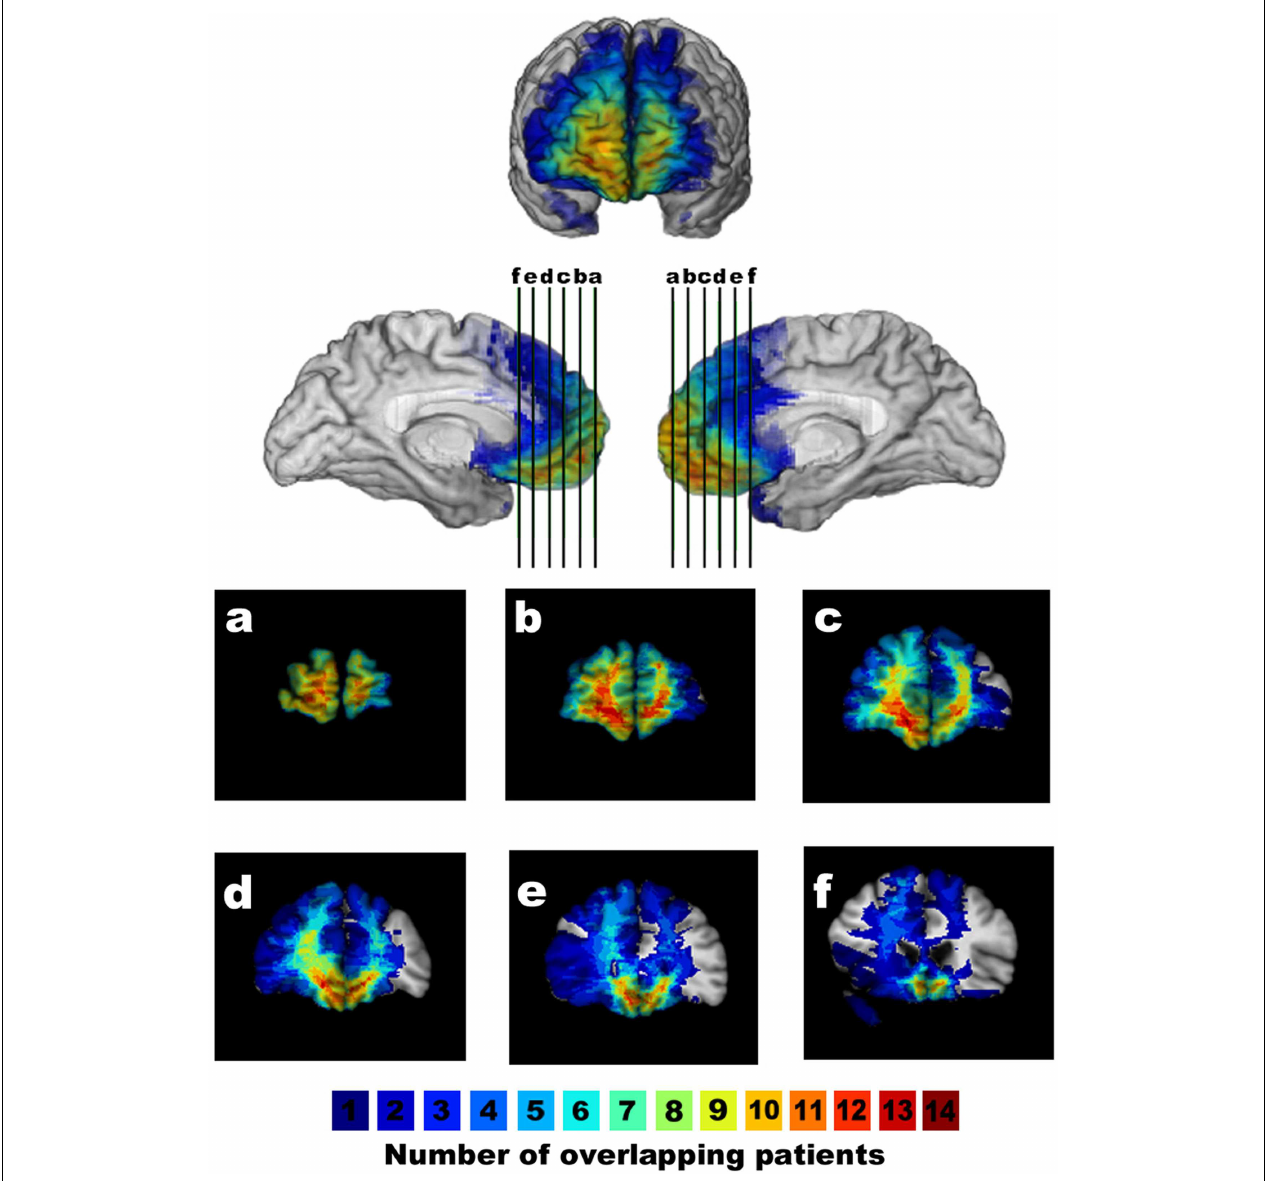
slices (a–f, with the right hemisphere on the left in the coronal views).The color bar indicates the number of overlapping lesions per